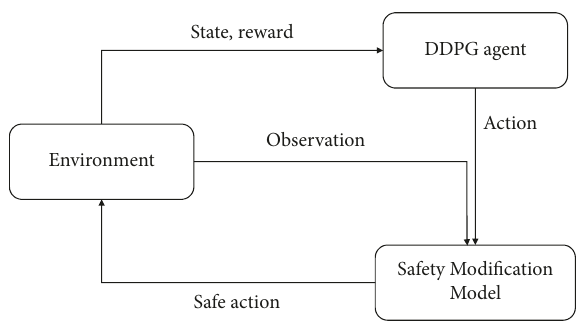
Figure 7: Modification for the DDPG